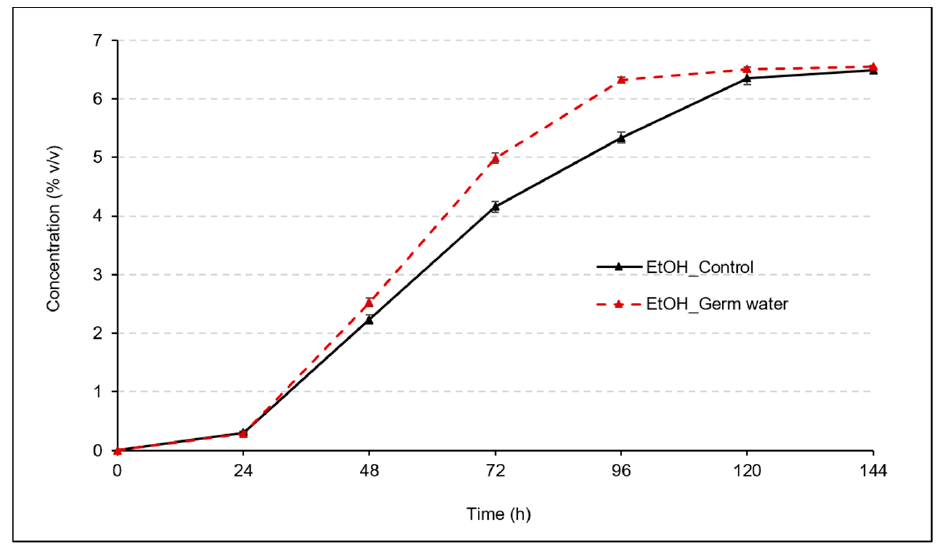
Figure 2. Ethanol concentration during fermentation without (control) and with addition of germ soak water.